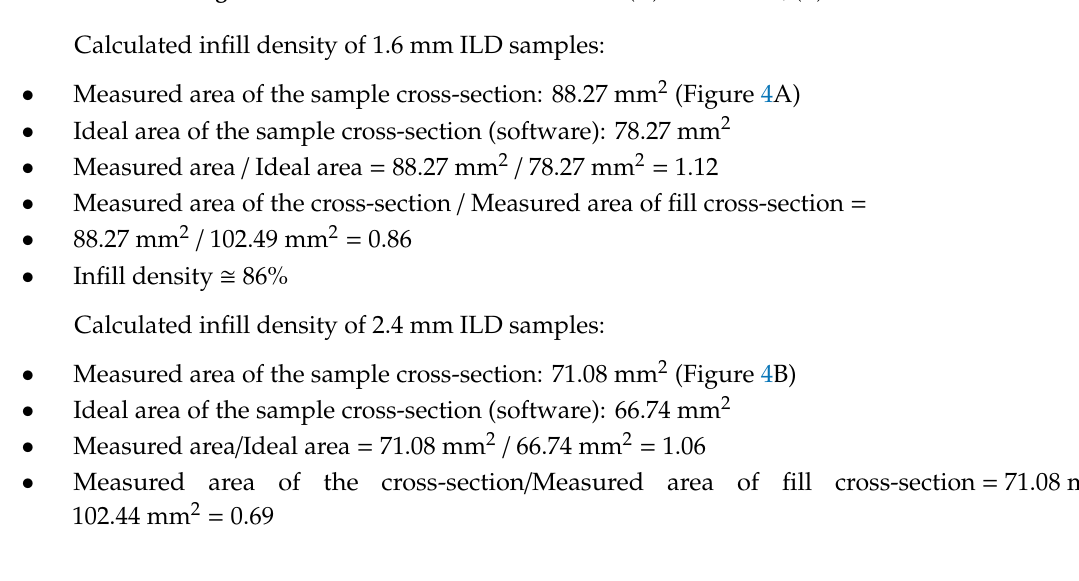
Figure 5. Area measurement of fill surface: (A) 1.6 mm ILD, (B) 2.4 mm ILD.